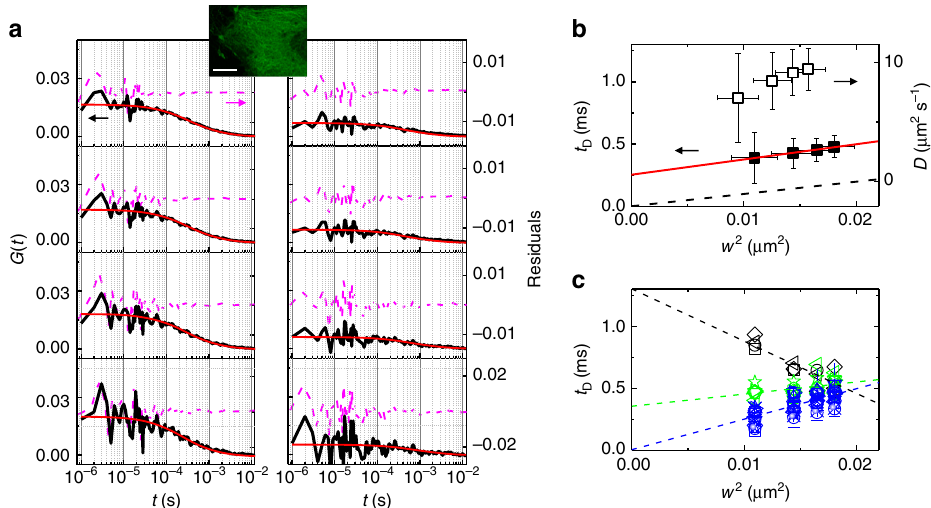
Fig. 4 SPLIT-FLCS of tubulin-EGFP in the cytoplasm of live cells. a Representative fi ltered ACFs of tubulin-EGFP in the cytoplasm of HeLa cells at a STED power of 50 mW for different values of the parameter r 1 ( r 1 = 11 w 0 , 4 w 0 , 2 w 0 , w 0 , respectively, from top to bottom ). Shown are two experimental measurements taken as representative of fast ( left ) and slow ( right ) diffusion, respectively. Solid lines are a fi t of the data to Eq. (15). Residuals are shown on the right axis. The image of a cell is shown in the inset (scale bar 10 μ m). b Transit time t D and apparent diffusion coef fi cient D for different spatial scales, obtained as the average of single-point measurements in the cytoplasm of HeLa cells ( n = 32, mean ± s.d.). The solid red line is a linear fi t to the data. The dashed line represents a Brownian motion with D = 25 μ m 2 s − 1 . c Transit time t D at different spatial scales for all the single-point measurements. The data have been grouped into three categories depending on the value of transit time t D measured at the smallest spatial scale ( w = 104 nm): t D < 0.4 ms (blue), 0.4 ms < t D < 0.7 ms (green), t D > 0.7 ms (black). The dashed lines are linear fi ts of the average of each